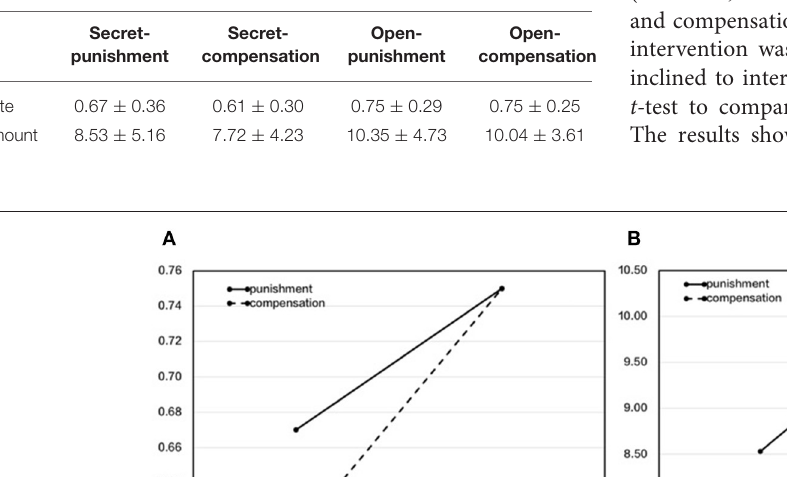
TABLE 4 | Transfer rates and amounts when third parties were not free to choose ( M ± SD ).